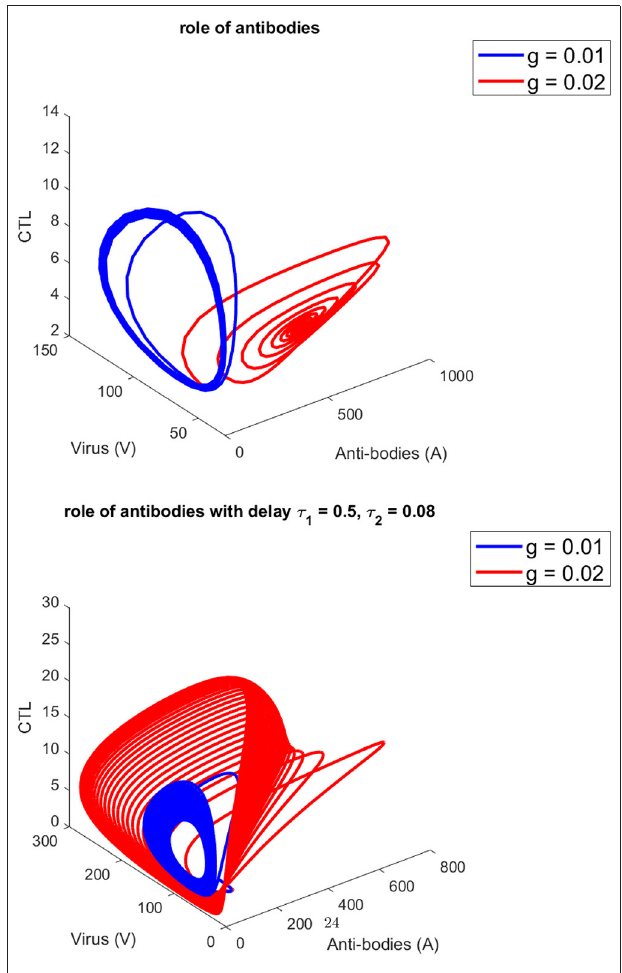
FIGURE 4 | For three different values of g . (Top) without, (Bottom) (with) delay τ 1 0.5, τ 2 = =